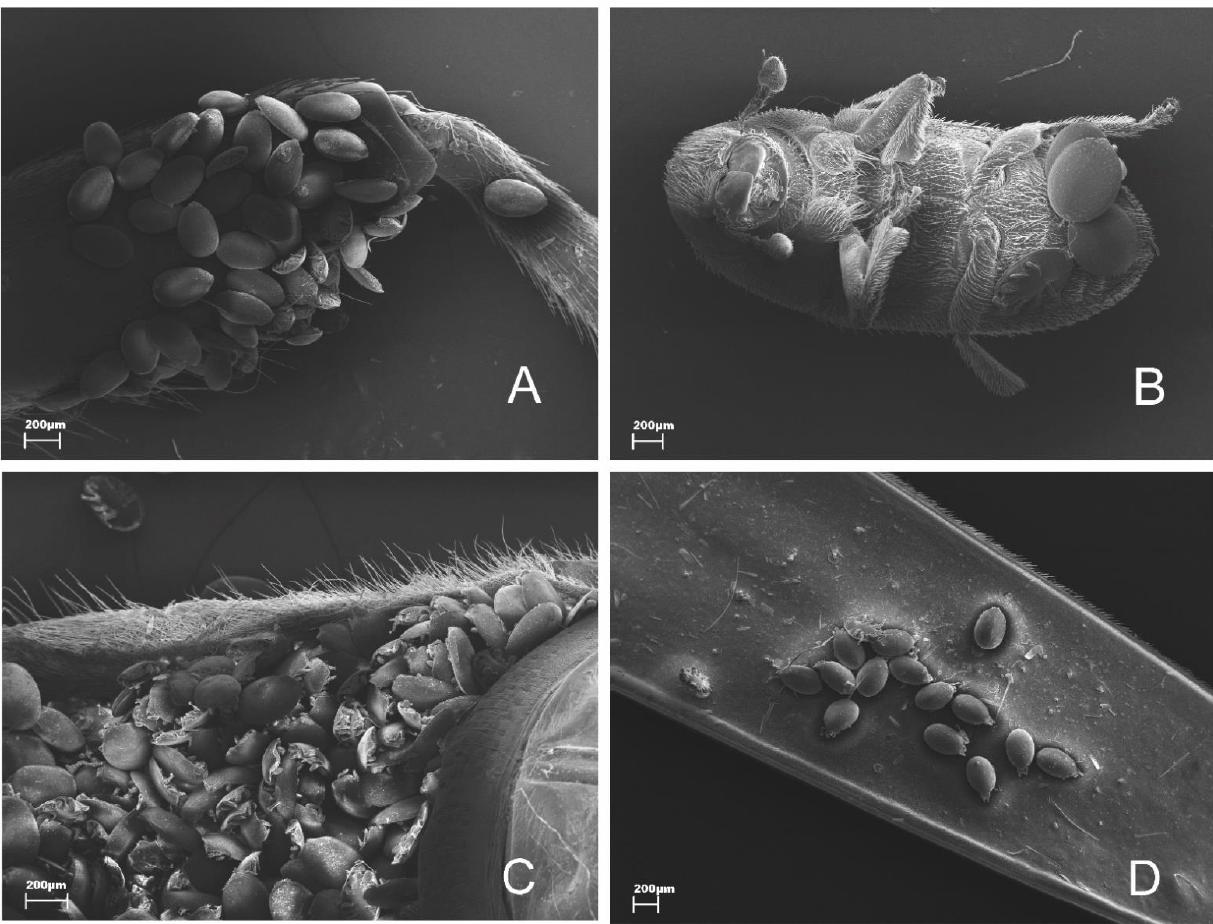
Figure A1. SEM micrographs of phoretic deutonymphs of Uropodina mites carried by on different parts of the insect: on the leg of a family Cerambycidae representative ( A ), on bark beetle (Scolytinae) ( B ), on abdomen ( C ), on subelytra ( D ). Table A1. Species composition and structure of Uropodine mites communities the in dead wood in the examined areas: PB –Białowieża Primeval Forest, RC–Cisy Staropolskie im. Leona Wyczółkowskiego Nature Reserve, RJ– Jakubowo Nature Reserve, RL –Las Grądowy nad Mogilnicą Nature Reserve, RBB–Bytyńskie Brzęki Nature Reserve, RBG–Brzęki przy Starej Gajówce Nature Reserve, RHG – Huby Grzebieniskie Nature Reserve. S – soil, DW – dead wood; D – dominance, F – frequency. Bold – dominant and the most frequent species.